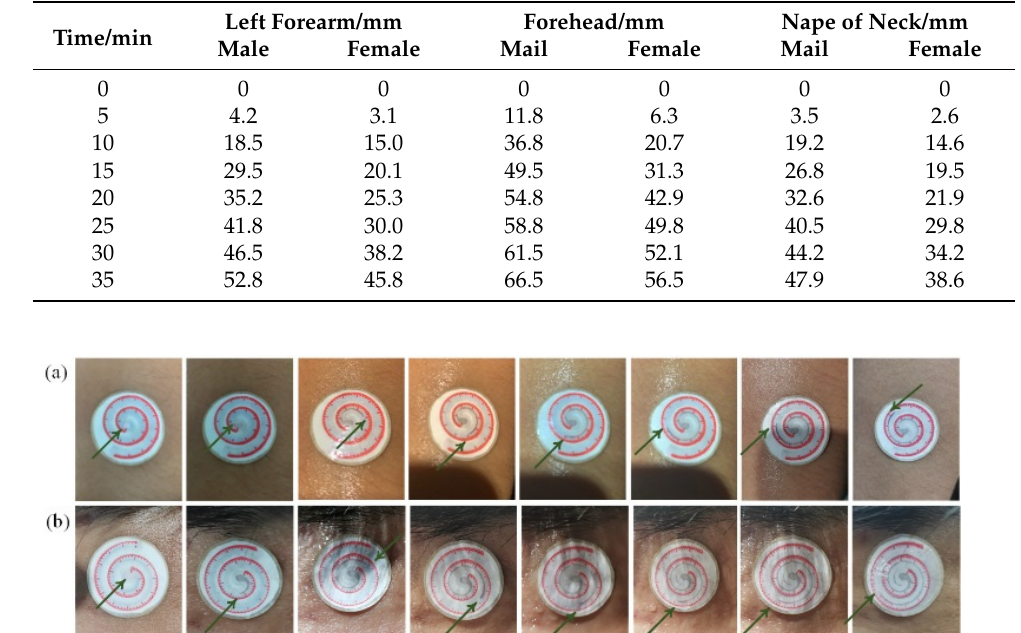
Table 1. Record of test results for human volunteers.